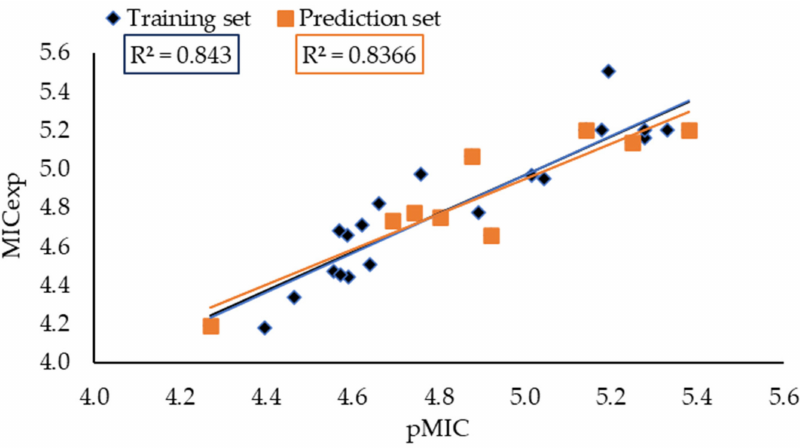
Figure 2. Correlation between experimental and predicted anti-TB activity values.